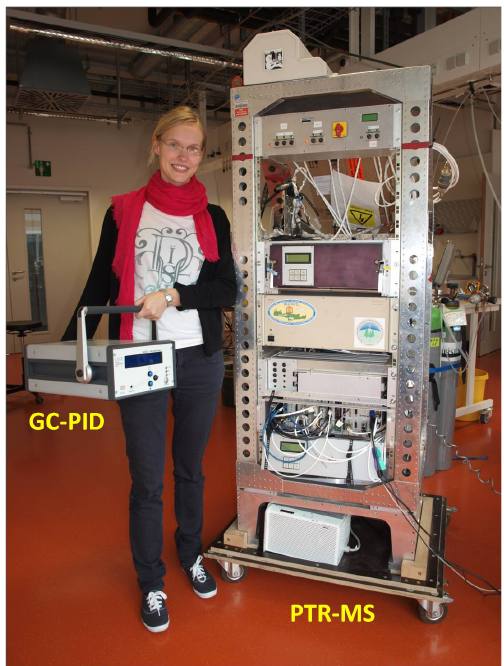
Fig. 6. Two detectors for CRM total OH reactivity measurements: To the right the IONICON PTR-MS, to the left the GC-PID.